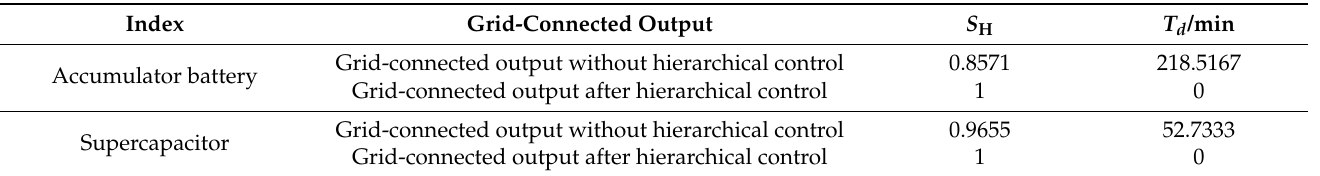
Table 2. Comparison of stabilization effect